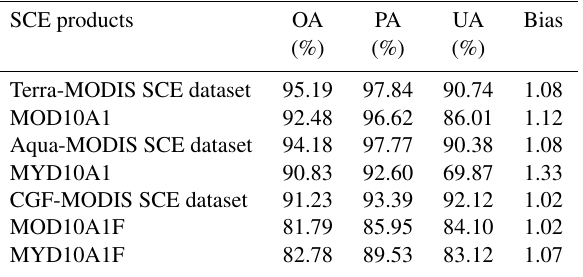
Table 7. Validation and comparison at four forest CMA